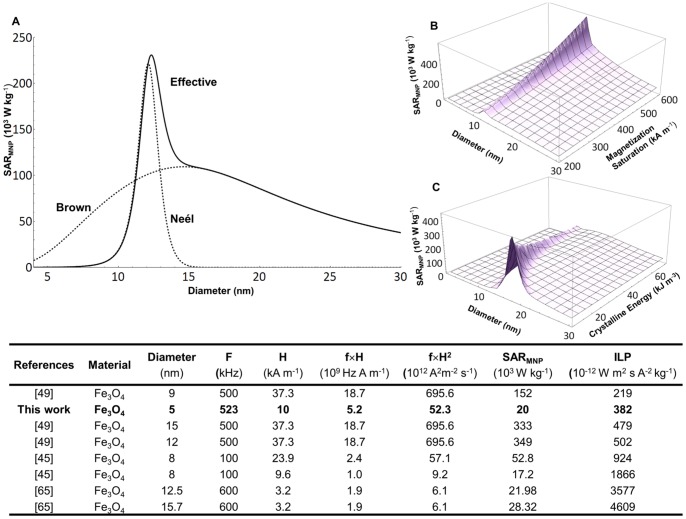
Modulating the SARMNP of SPIOs.
(A) Theoretical specific absorption rate of magnetic nanoparticles SARMNP as a function of the diameter. The Brown and Neel relaxation curves are also presented. (B, C) The variation of SARMNP with the magnetization saturation and crystalline energy of the SPIOs. The table lists SAR and ILP values for magnetite-based nanoparticles presented in the literature.